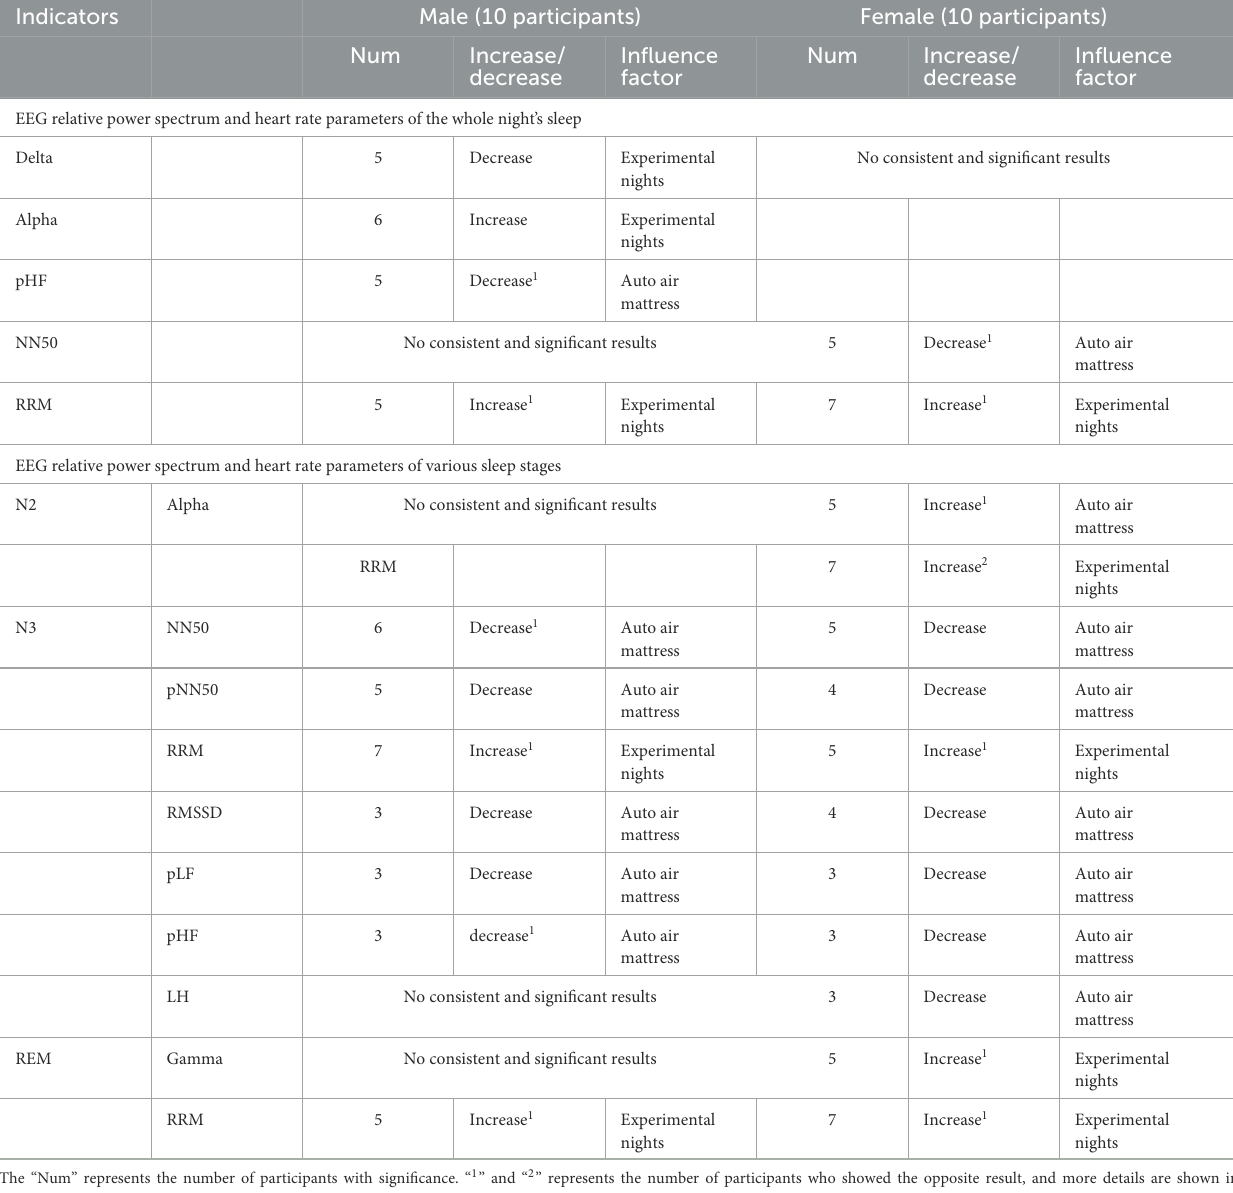
TABLE 4 The results of EEG relative power and heart rate parameters.